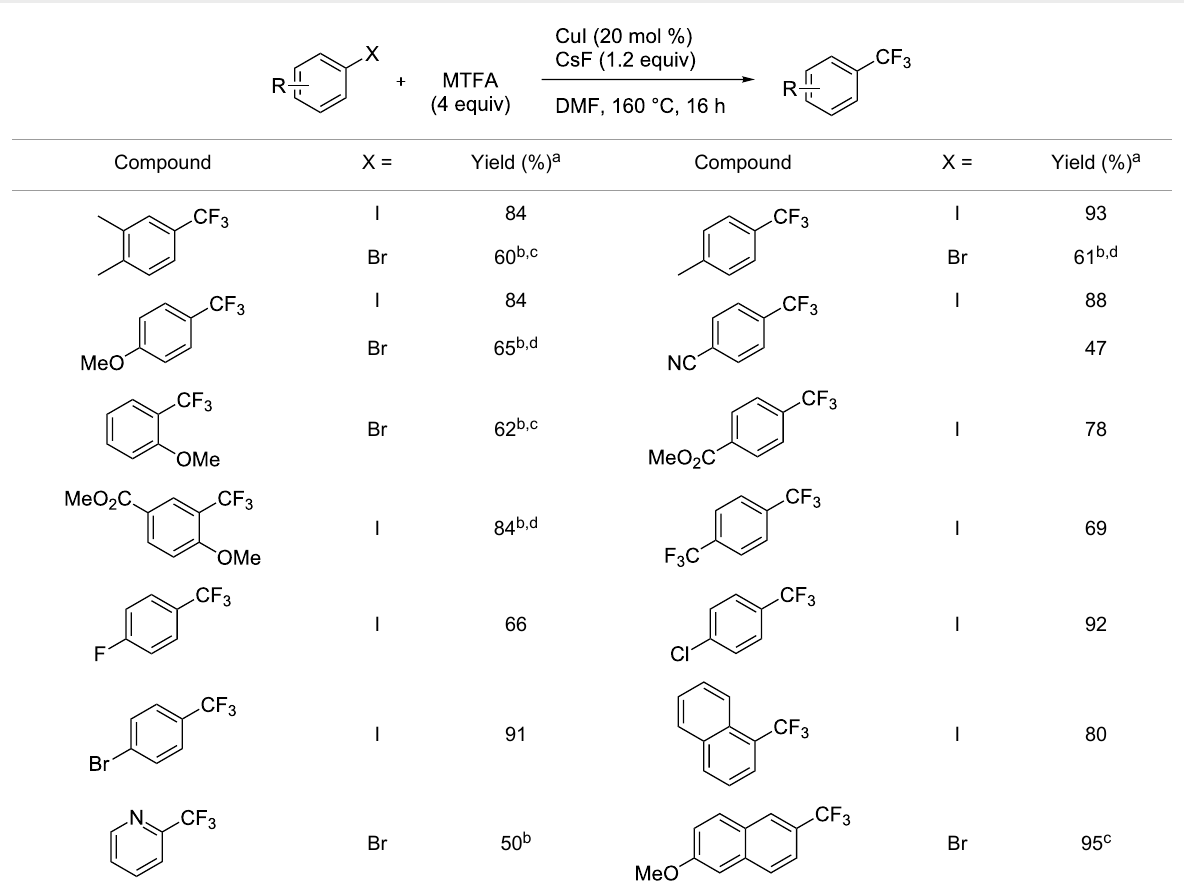
Table 15: Cu-catalyzed trifluoromethylation of (hetero)aryl iodides and aryl bromides with methyl trifluoroacetate